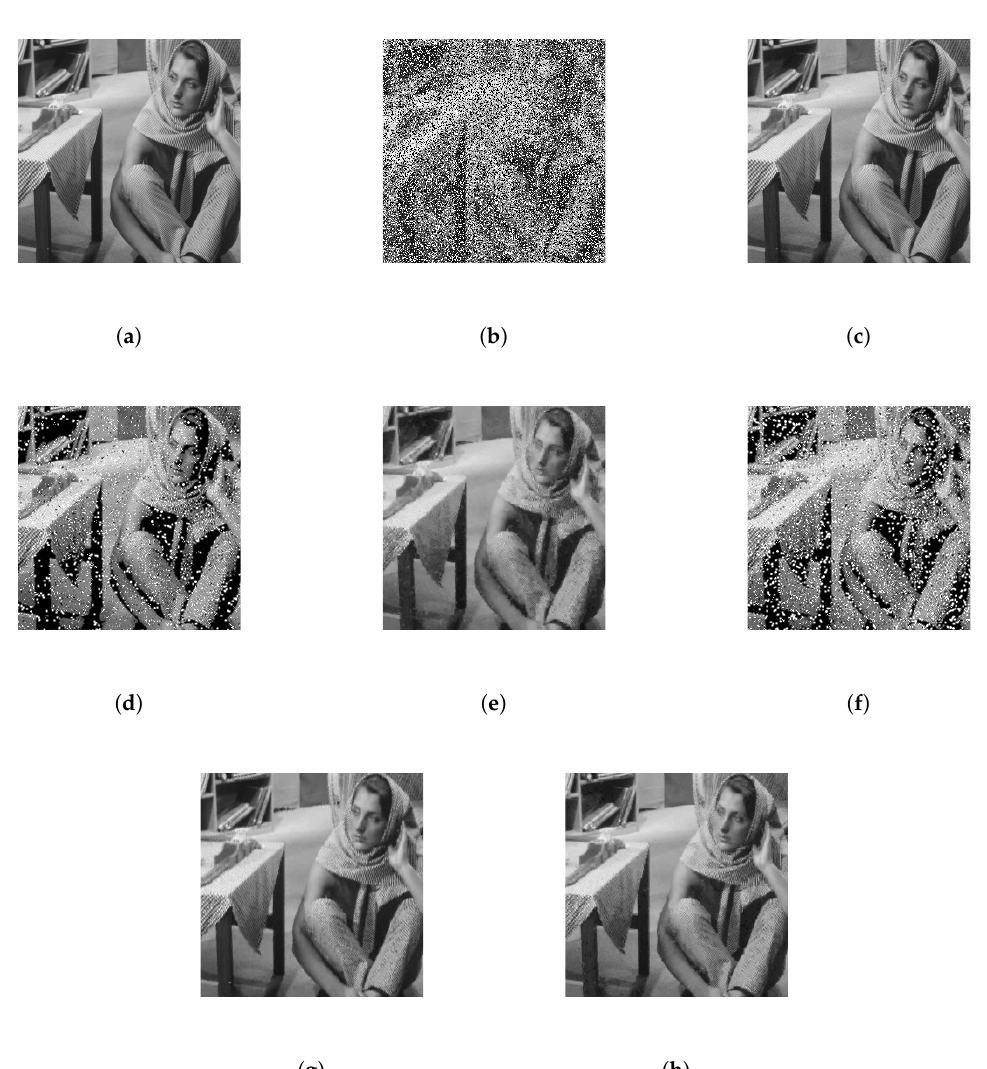
Figure 4. Restoration results of different algorithms under random data missing only. ( a ) original image; ( b ) corrupted image with 70% missing (7.23 dB); ( c ) reconstructed image obtained by framelet+APG (29.1 dB); ( d ) reconstructed image obtained by framelet+ADMM (26.7 dB); ( e ) reconstructed image obtained by wavelet+APG (25.9 dB); ( f ) reconstructed image obtained by wavelet+ADMM (23.6 dB); ( g ) reconstructed image obtained by BPFA (27.8 dB); ( h ) reconstructed image obtained by FoE (28.3 dB). FoE: fields of experts.